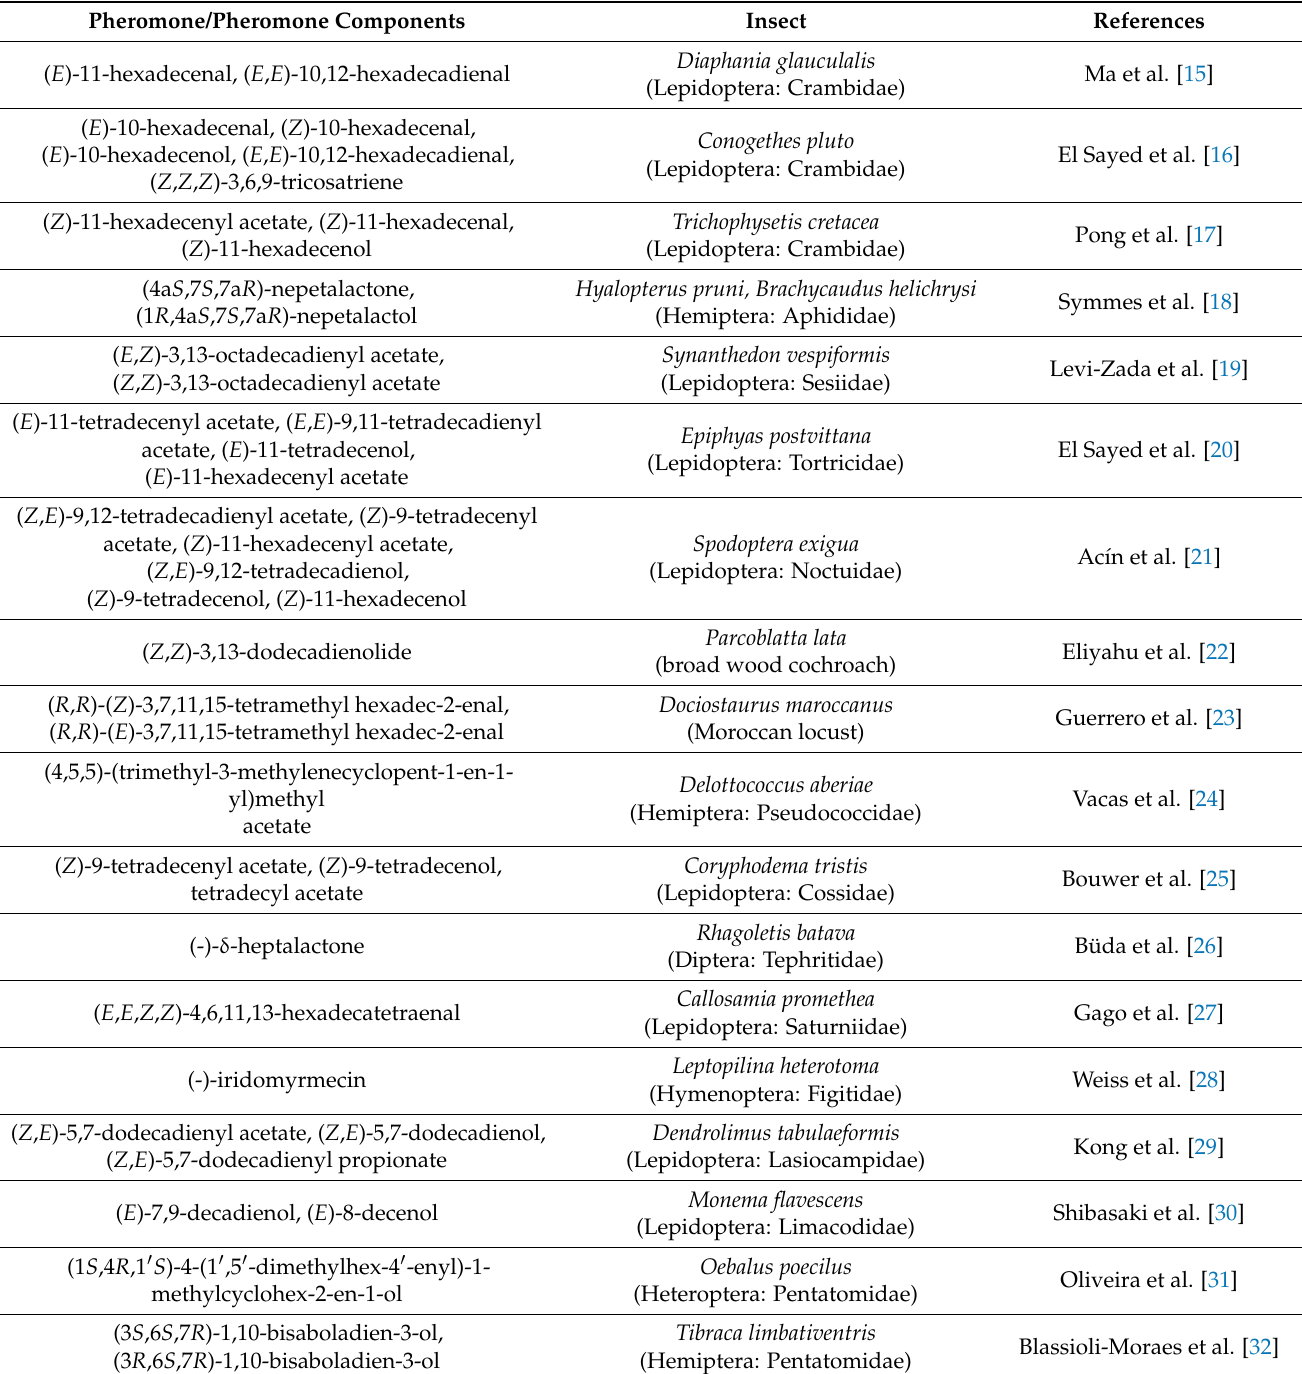
Table 2. New sex pheromones and sex pheromone components recently identified from insect pests (2010–2020). Pheromone/Pheromone